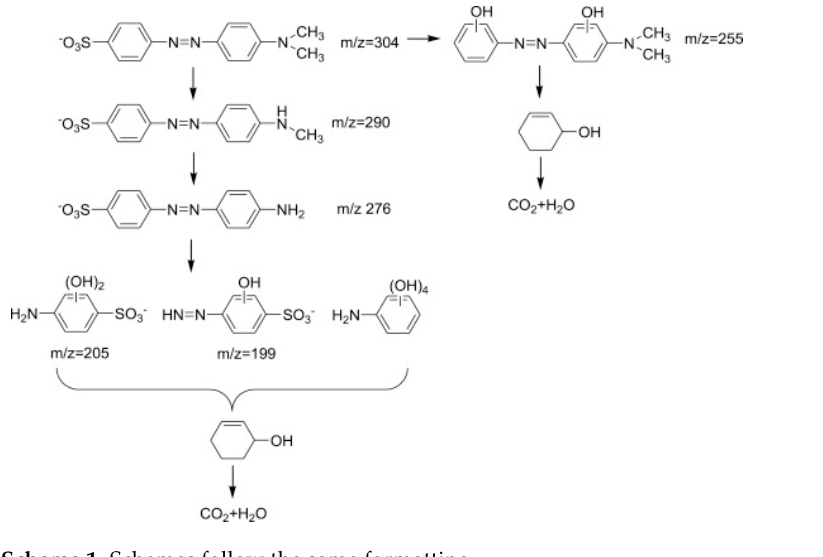
( d ) Figure 4. Photocatalytic properties of composites: ( a ) change in the absorption spectrum of MO aqueous solution with increasing time of its UV irradiation with the usage of copolymer of original